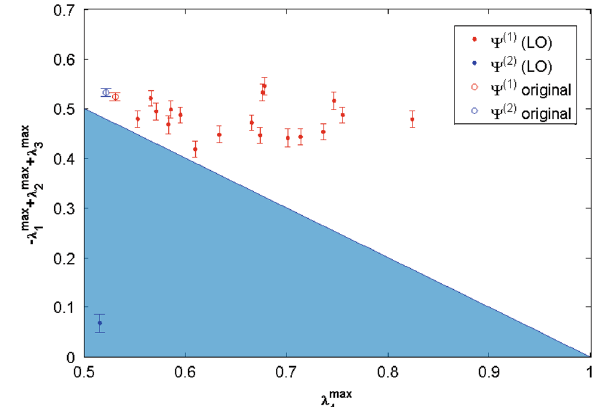
Fig. 4 Experimental results. The red and the blue circle are the local spectra of the original four qubit states. After applying local operations, the spectra are shown as the red and blue dots for | Ψ (1) 〉 and | Ψ (2) 〉 , respectively. The data points in the cyan region do not meet the constraint (4). Error bars are obtained by Monte Carlo simulation (1000 runs)